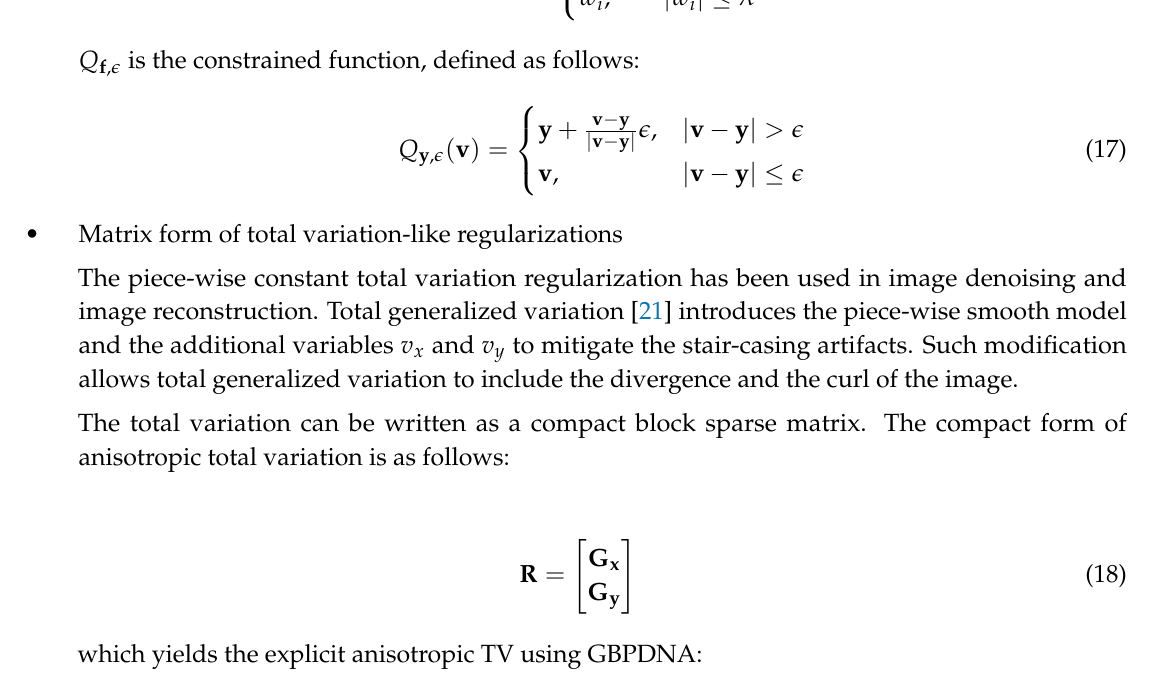
Algorithm 4: The pseudocode for the GBPDNA algorithm for anisotropic total variation x 0 = w 0 = 0 , v 0 = z 0 = hx = hy =